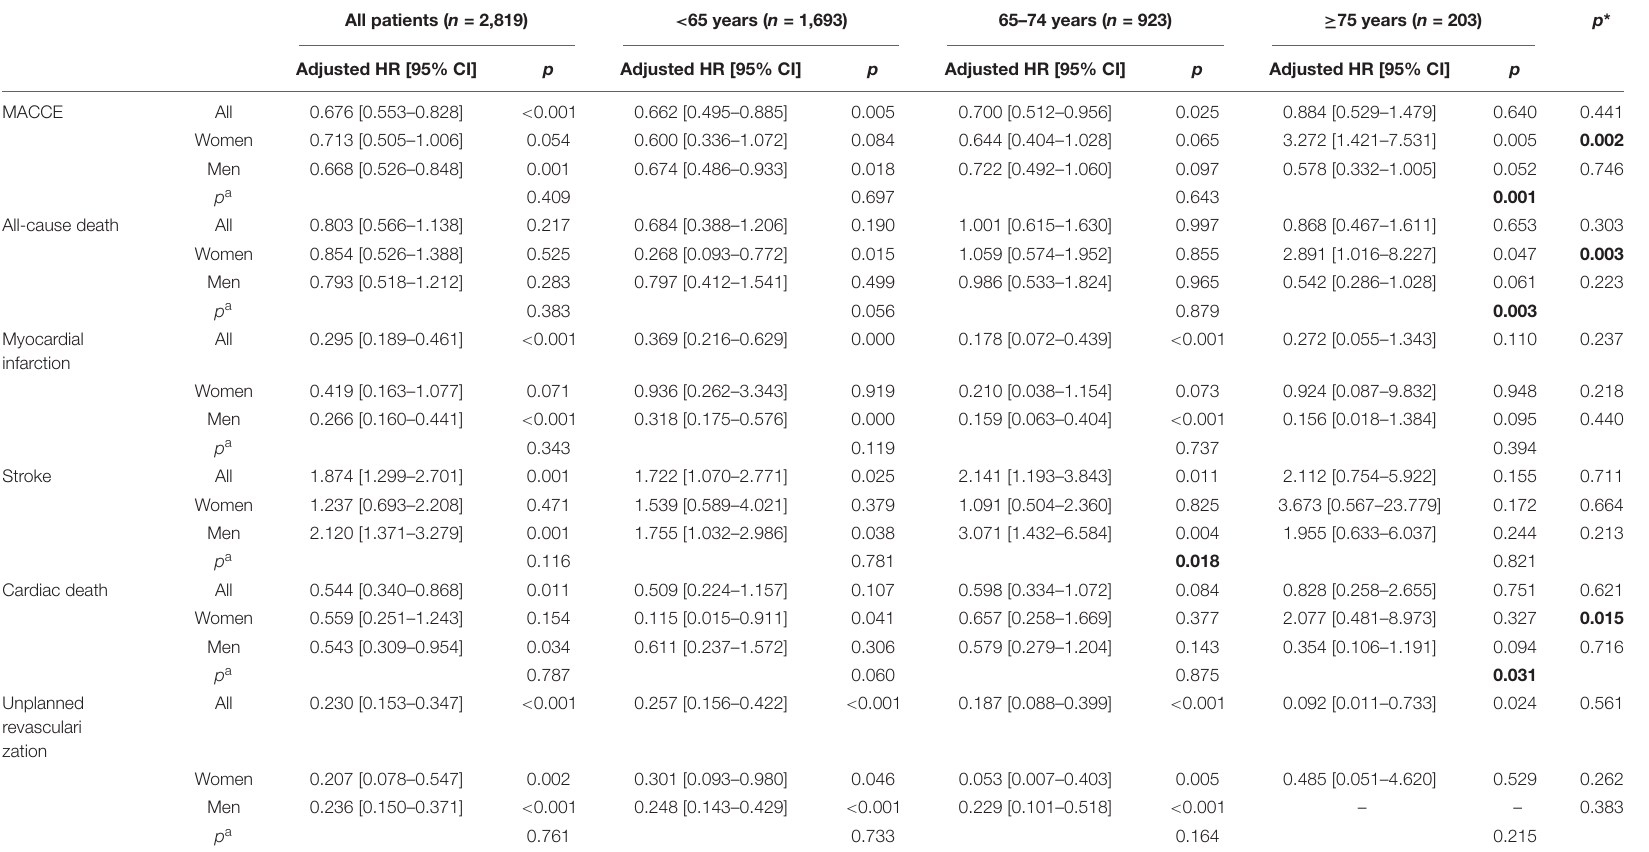
TABLE 2 | IPTW-adjusted risks of CABG relative to PCI for clinical